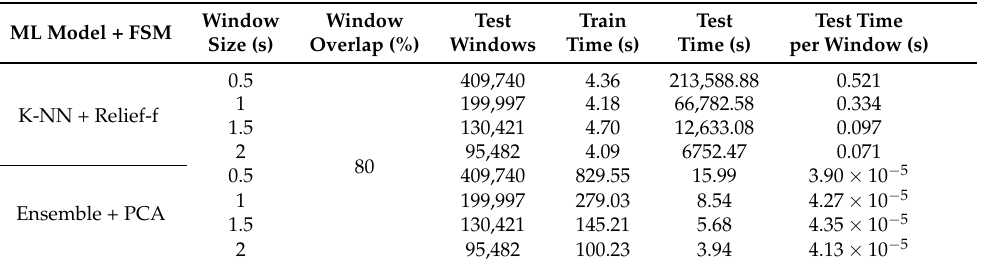
Table 12. Classification time for the training and testing of the two best combinations of Machine Learning (ML) model and Feature Selection Method (FSM), for each of the selected windows for the window size